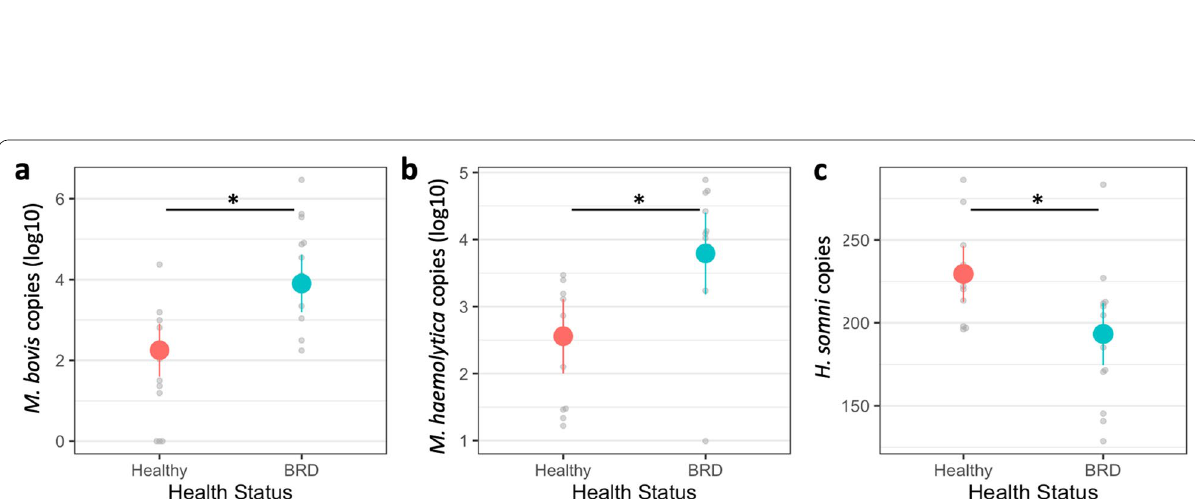
Fig. 4 Prevalence of BRD pathobionts in the nasal microbiota of Holstein steers (n steer pen‑mates according to clinical signs. Prevalence of Pasteurella multocida ( a ), Mannheimina haemolytica ( b ) , Histophilus somni ( c ) and Mycoplasma bovis ( d )